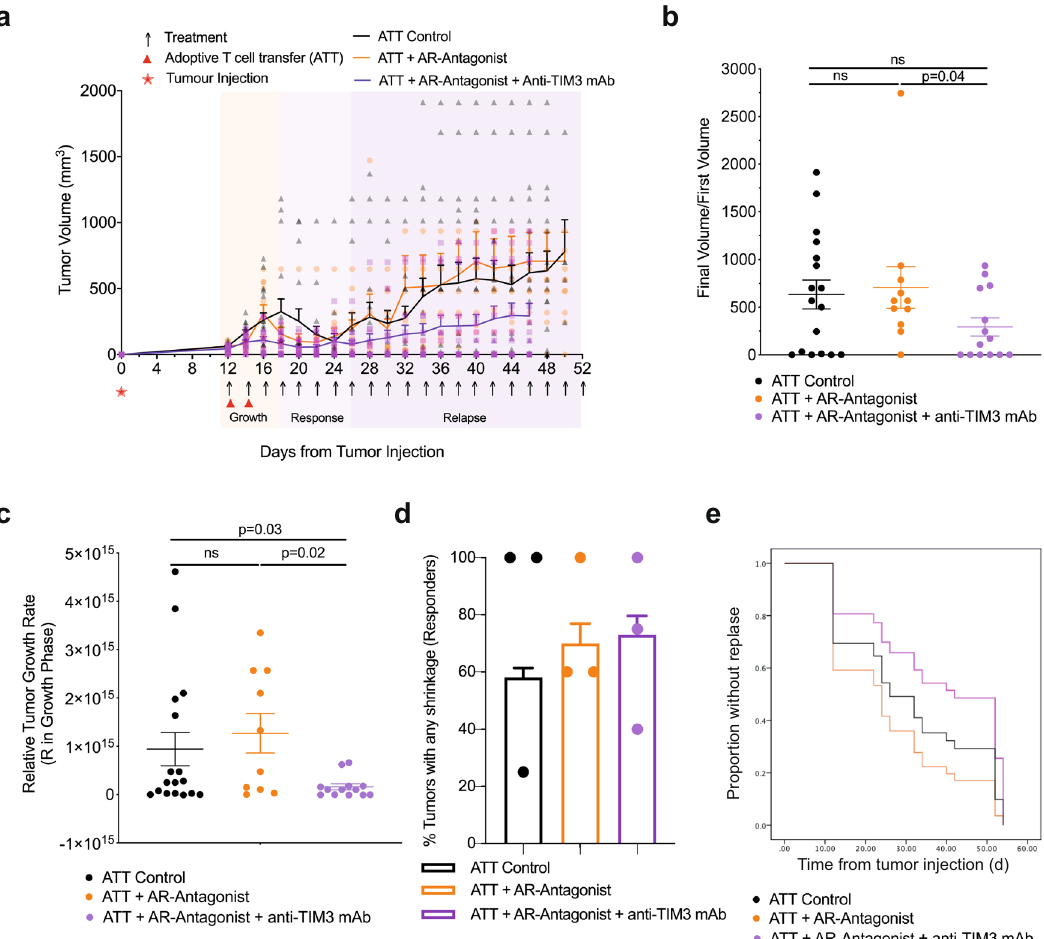
Fig. 3 A 2A R antagonist and anti-TIM3 mAb synergistically suppress RencaHA tumor growth. a RencaHA tumor-bearing BALB/c mice were injected i.v. twice with 5 × 10 6 puri fi ed CL4 CTL on days 12 and 14 and treated with A 2A R-antagonist, anti-TIM3 mAb, or vehicle + isotype-control antibody, as shown. Tumor growth is displayed as mean tumor volumes + SEM with N = 42 mice over three independent experiments, with at least 11 mice per group. b The ratio of fi nal to initial (day 12) tumor volume of tumors in a is given with the mean ± SEM (independent two-sample t -test). c R -values representing the growth rate of tumors in a, between 12 and 16 days, are given with the mean ± SEM (independent two-sample t -test). d Proportion of tumors across all experimental replicates in a which were regressed are given as bars ±SEM with proportion in individual experimental replicates as dots. Neither analysis of pooled data using Fisher ’ s exact Boschloo test nor of experimental replicates using 1-way ANOVA yield signi fi cant differences. e Progression free survival of mice in a is given. Cox Proportional Hazards Regression analysis. Treatment did not signi fi cantly predict progression free survival: ( p = 0.24 ATT control; p = 0.40 ATT + A p = 0.30 ATT + A + Anti-TIM3 mAb). Hazard ratio of progression versus Control was as follows: 2A R-Antagonist; 2A R-Antagonist ATT + A 2A R-Antagonist = 0.36 (0.61 ± 3.38), ATT + A 2A R-Antagonist + Anti-TIM3 mAb = − 0.53 (0.21 ± 1.63). Source data are provided in Supplementary Data